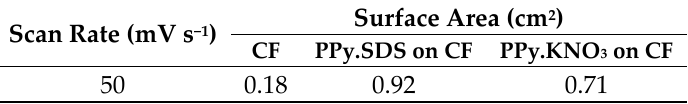
Figure 4. ( a ) Post-polymerisation cyclic voltammetry of PPy.SDS and PPy.KNO 3 on carbon fibre; ( b ) Cyclic voltammograms obtained for the fibre electrodes in 10 mM K 3 Fe(CN) 6 and 0.1 M KCl solution at a scan rate of 50 mVs − 1 . Table 1. Surface area of uncoated carbon fibre and PPy-coated carbon